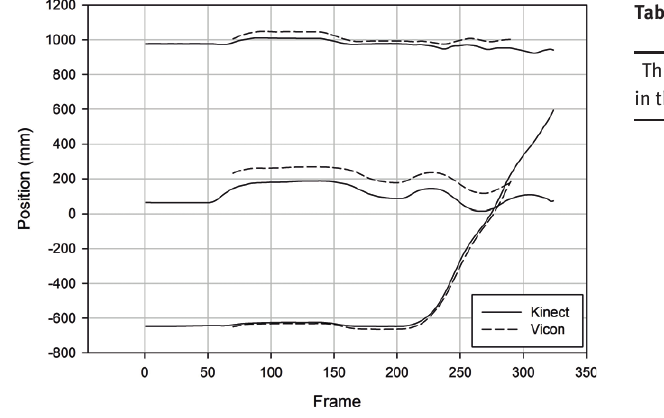
Fig. 6: Graph of center of mass for test 2 ( R 2 x = 0.9993, R 2 y = 0.9958, R 2 z = 0.8545).